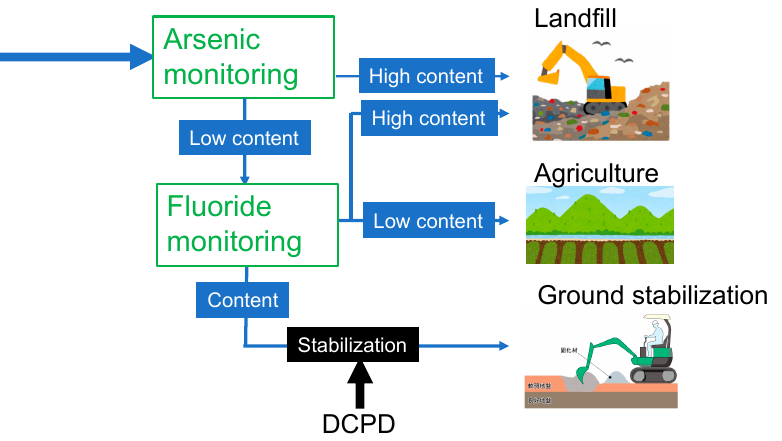
Figure 7. Potential advantages of our findings for the safe reprocessing of recycled gypsum obtained from waste plasterboards. DCPD: dicalcium phosphate dihydrate.